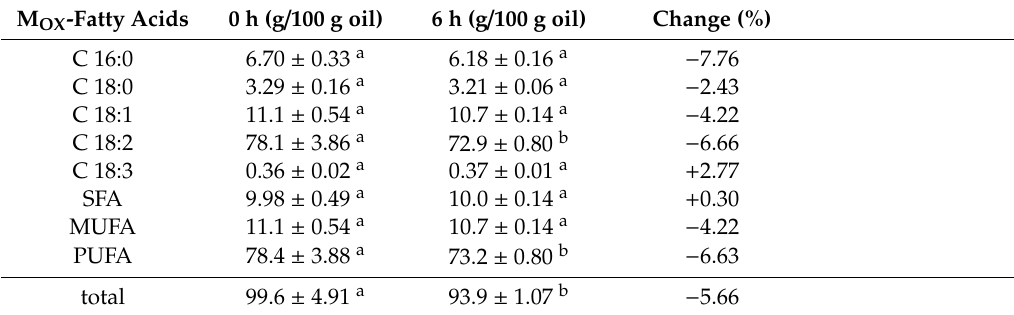
Table 3. E ff ects of gastric in vitro digestion of cold-pressed grape seed oils on fatty acid composition (g / 100 g oil) and the amount of tocopherols (mg / kg oil) 1 . M OX -Fatty